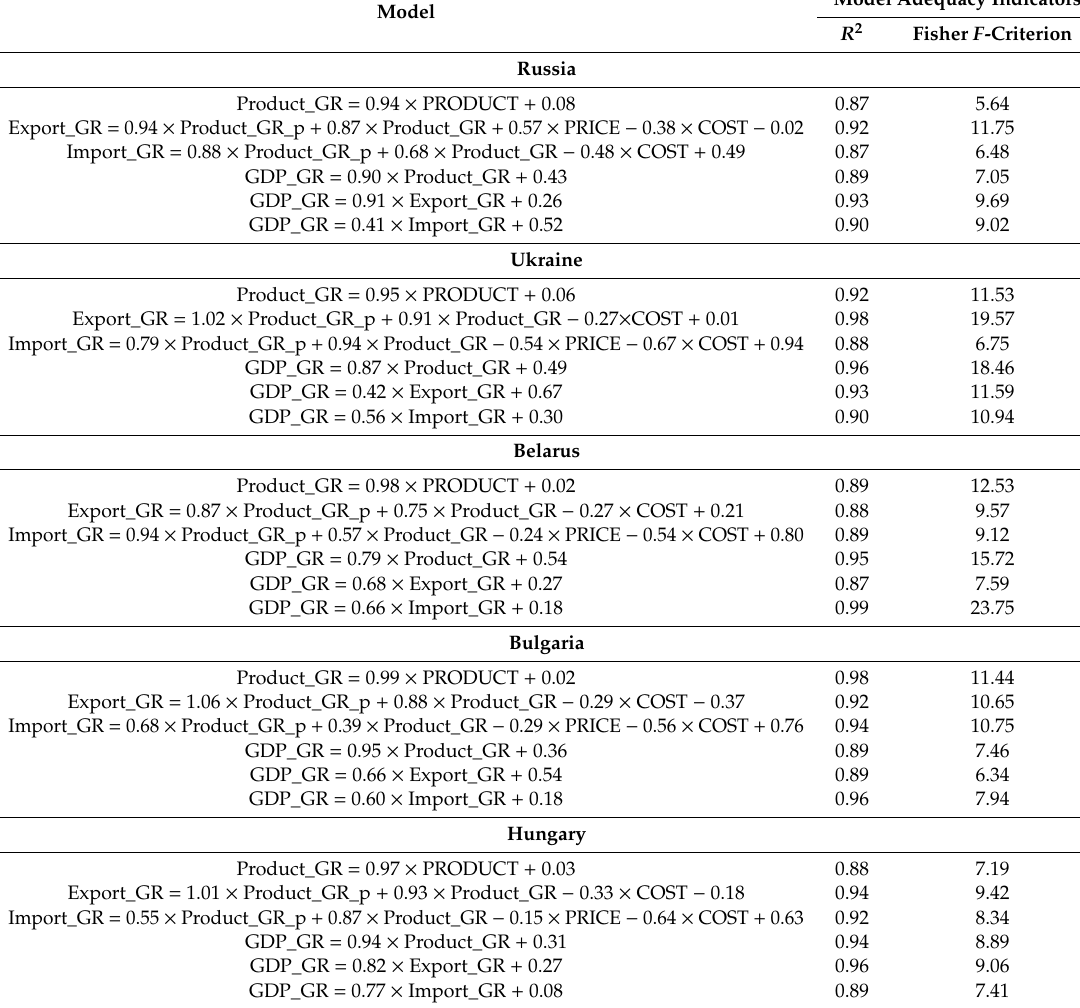
Table 3. Calculation model for the impact of the pandemic onto the Eastern European